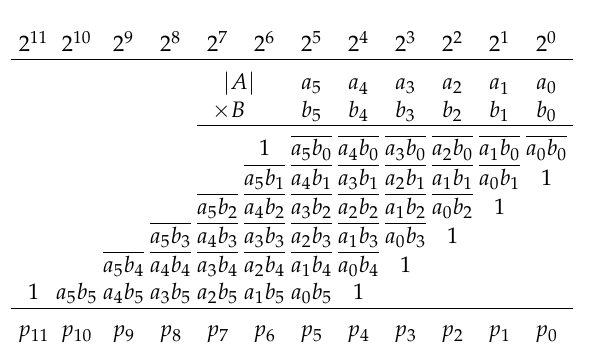
Figure 4. Proposed ( m × n )-bit KCM, where m = n = 6, A is a negative constant and B is a signed variable. This method allows a KCM with a negative constant to be implemented using the same resources as a KCM with a positive constant at the same